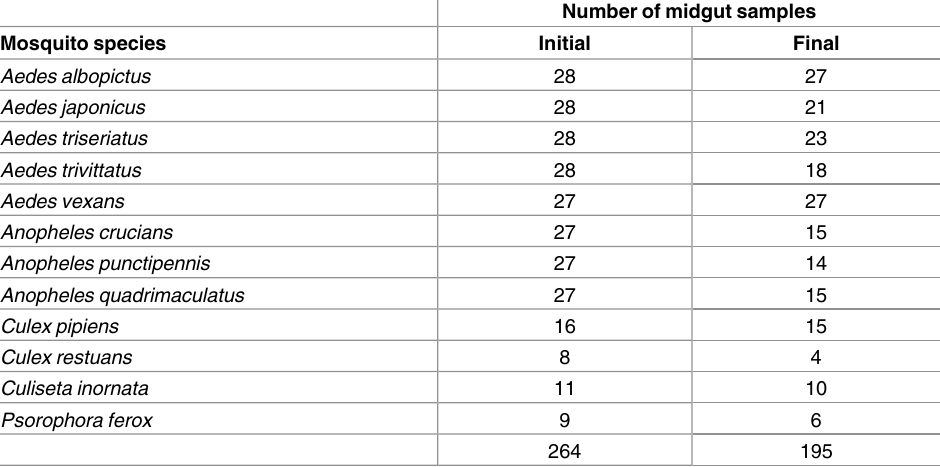
Four μl of sample was loaded in the sample inlets and 4 μl of primer loaded in primer inlets of a previously primed Fluidigm 48.48 Access Array IFC. The IFC was placed in an AX control- ler (Fluidigm Corp.) for microfluidic loading of all primer/sample combinations. Following the loading stage, the IFC plate was loaded on the Fluidigm Biomark HD PCR machine and sam- ples were amplified using the following Access Array cycling program without imaging: 50˚C Table 1. Number of midgdut samples that were processed for each of the 12 mosquito species col- lected in Urbana-Champaign, IL. Number of midgut samples Mosquito